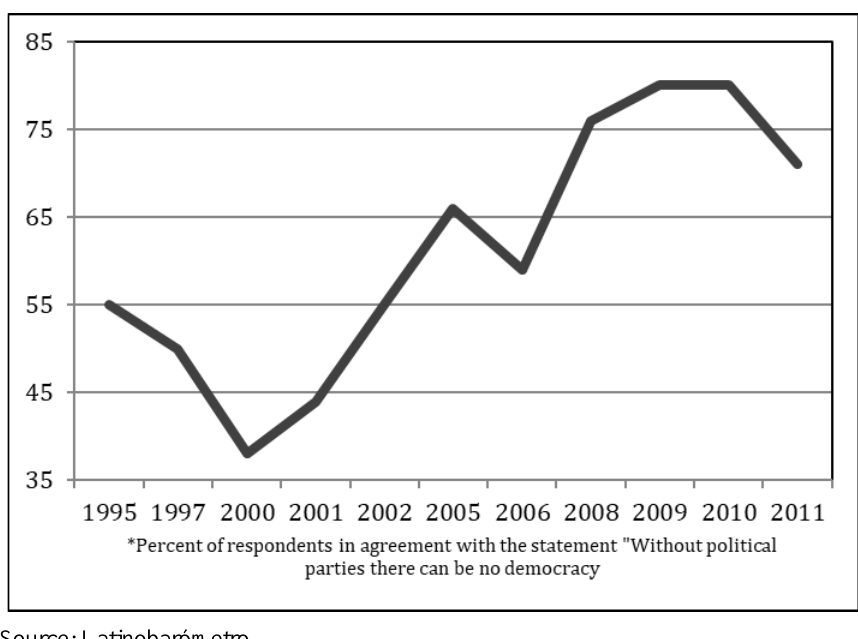
Figure 2 Support for Parties in Venezuela, 1995-2011